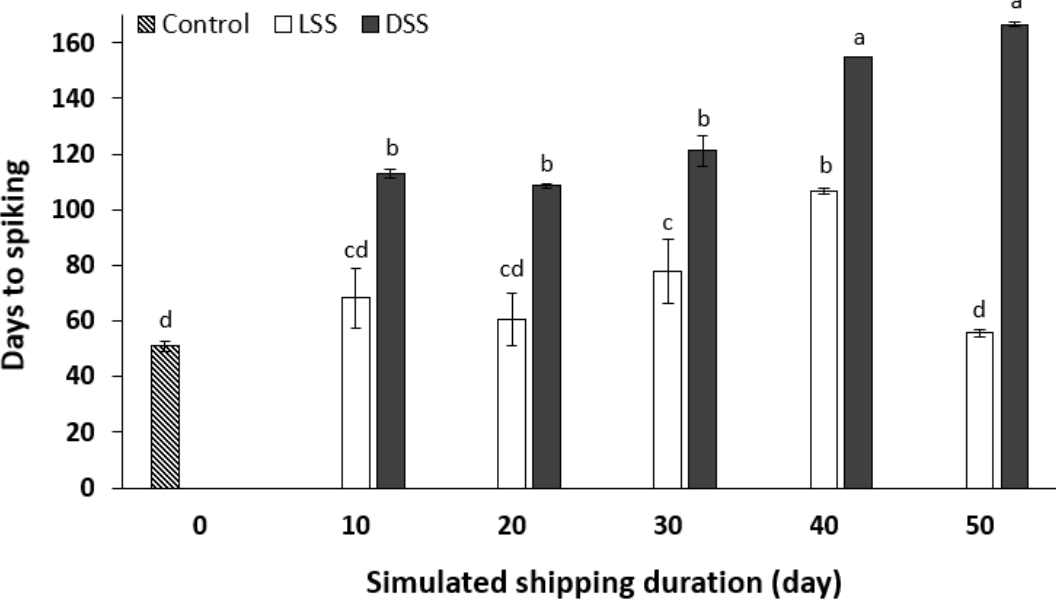
Figure 8. Days to spiking as influenced by simulated shipping duration in Phalaenopsis Sogo Yukidian ‘V3’. Within-graph means followed by the same letter are not significantly different according to Duncan’s multiple range test at p ≤ 0.05.